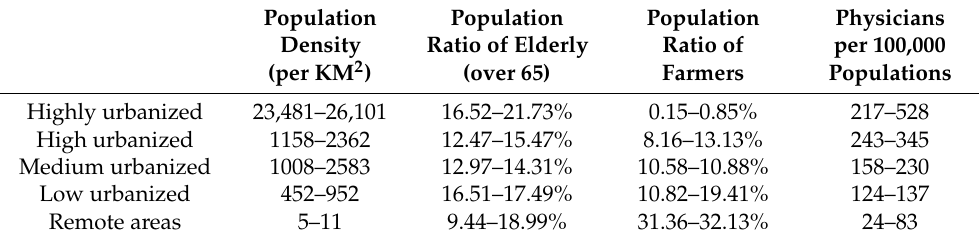
Table 1. Major factors measuring urbanization in Taiwan and their rough ranges [20].